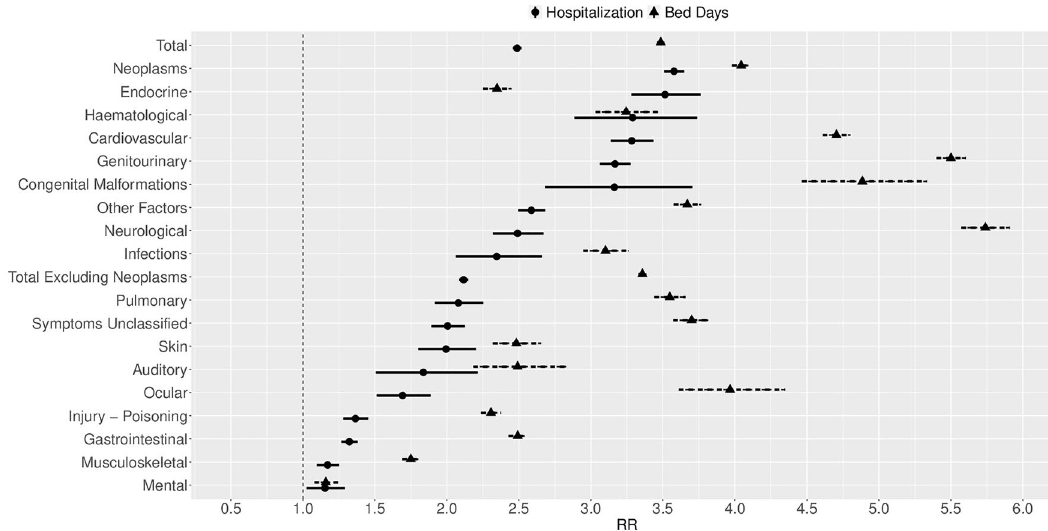
Figure 1. The relative hospitalisation ratio and the relative bed-day ratio according to the 10th revision of the International Classification of Diseases.